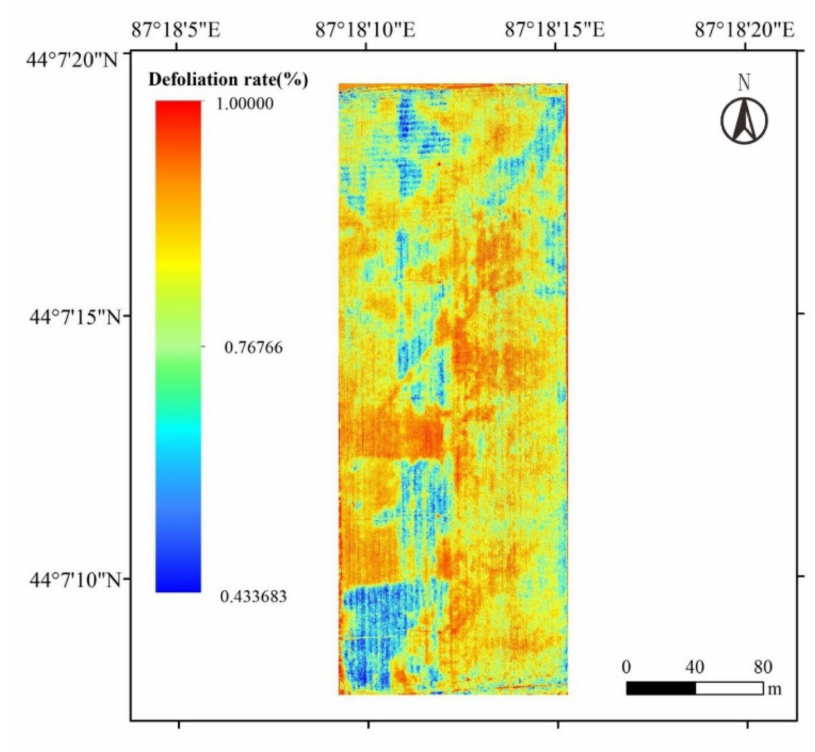
Figure 8. Prediction result of the cotton defoliation